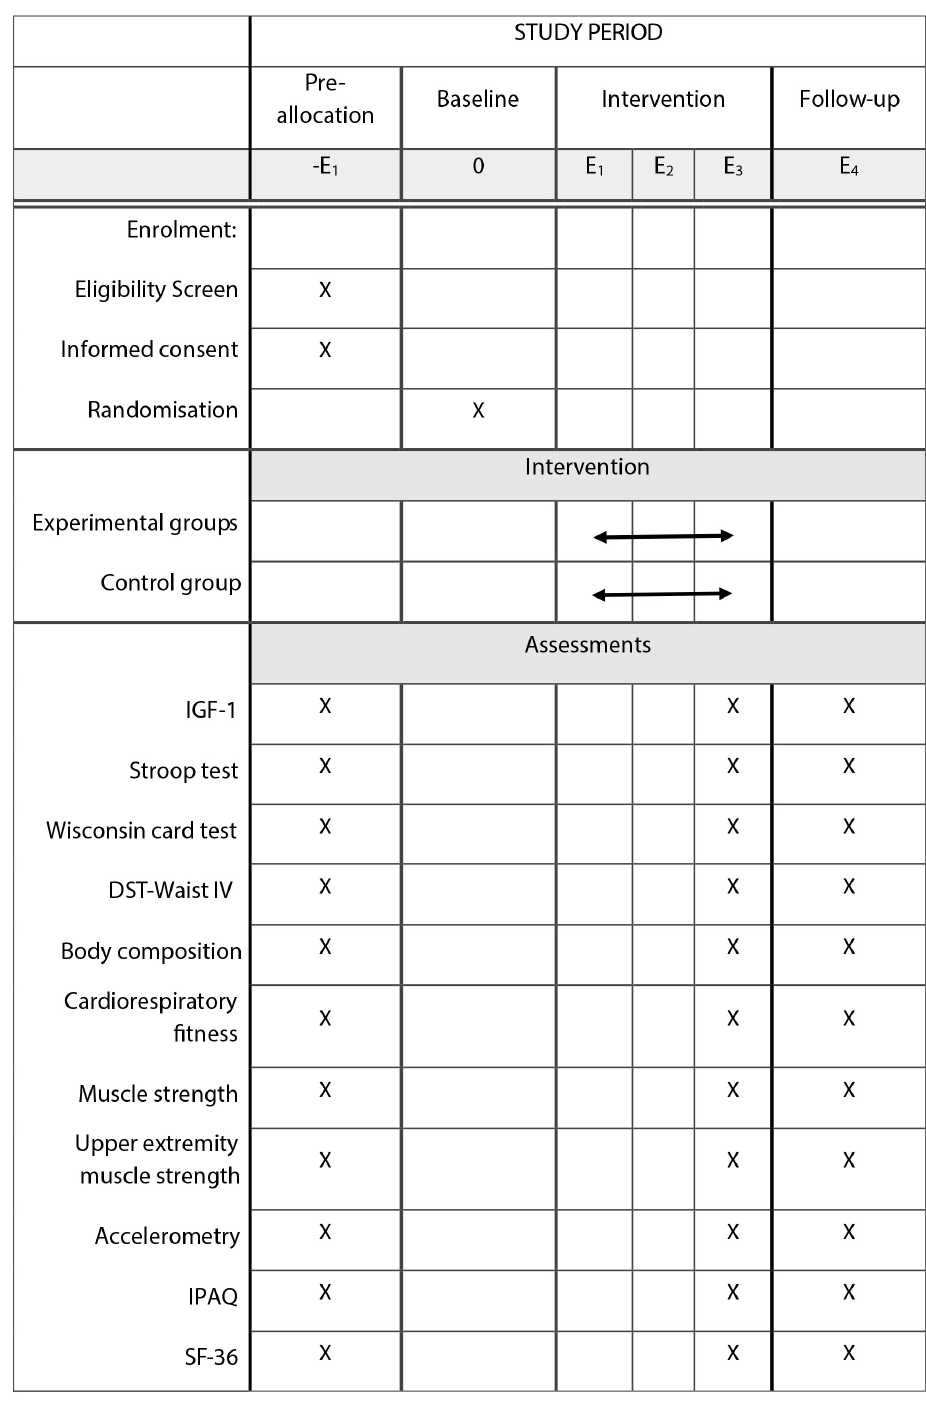
Figure 2. Schedule of enrolment, interventions and assessments in RCT.